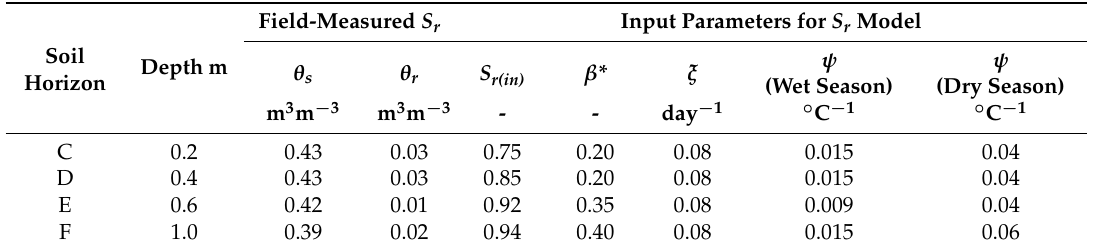
Table 3. Input data for the calculation of the degree of the soil saturation ( S r ).